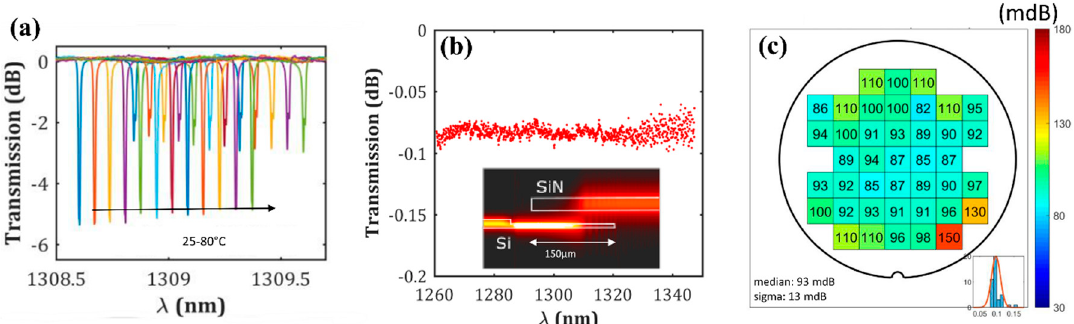
Figure 2. ( a ) SiN ring resonance shift against T. Each color represents a measurement at a different temperature, from 25 °C to 80 °C. The resonance shift with temperature allows to extract the SiN thermo-optic coefficient α = 1.7 × 10 − 5 K − 1 . ( b ) Measured spectrum of the Si-SiN transition insertion loss. Inset: side view of the transition with the optical mode from a BPM simulation. ( c ) Wafer mapping of the transition insertion loss (in mdB). Inset: histogram of the wafer level insertion loss. The median value is 0.09 dB and the standard deviation is 0.01 dB.